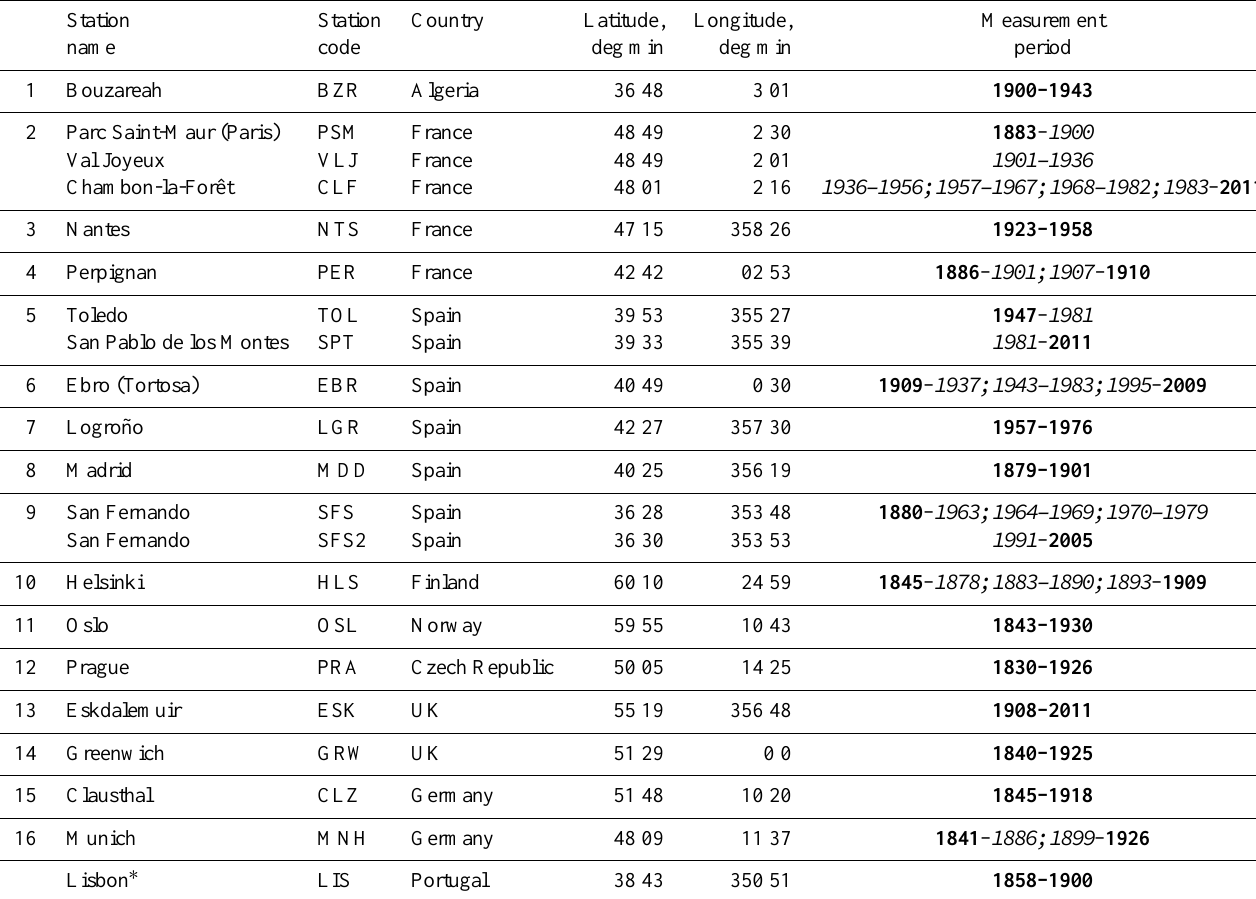
Table 4. A list of European and African stations used to obtain the reference series for COI D . Some stations have changes in the instruments and/or were re-located. The first and last years of each whole set are in bold, and intermediate dates are in italic.